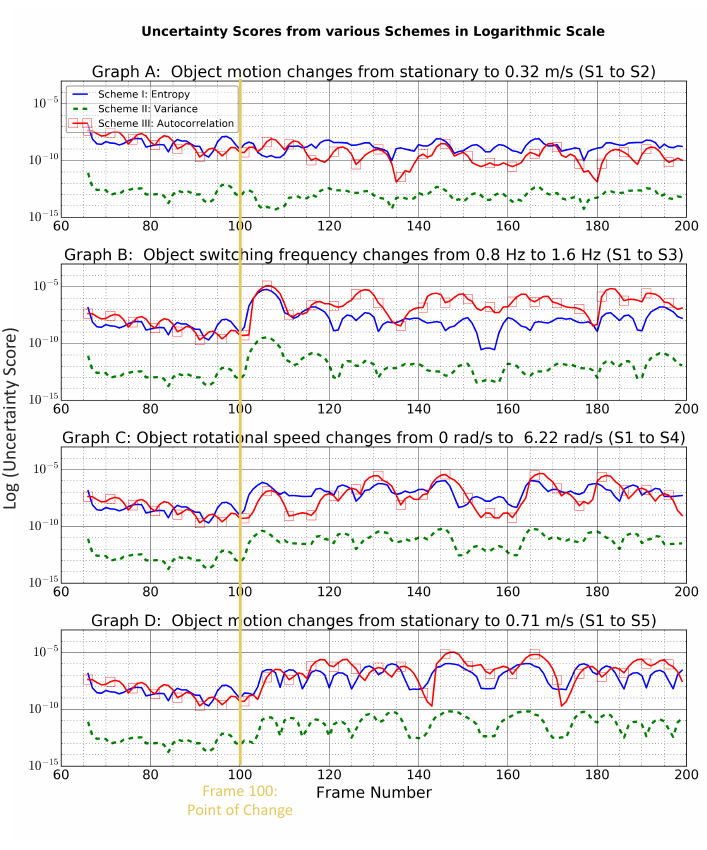
Figure 7. Uncertainty Scores in logarithmic scales from various uncertainty calculation